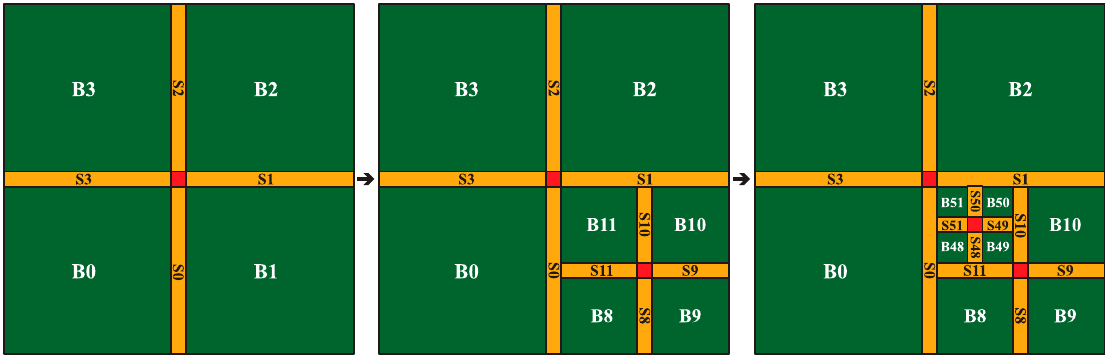
Figure 7. Determine values of Ids neighbour while an M-block splitting: ( a ) The adjacent DSSs of B 1 are 𝑆0 and 𝑆1 . ( b ) 𝐵1 splits into four child nodes. ( c ) 𝐵11 splits into four child nodes.